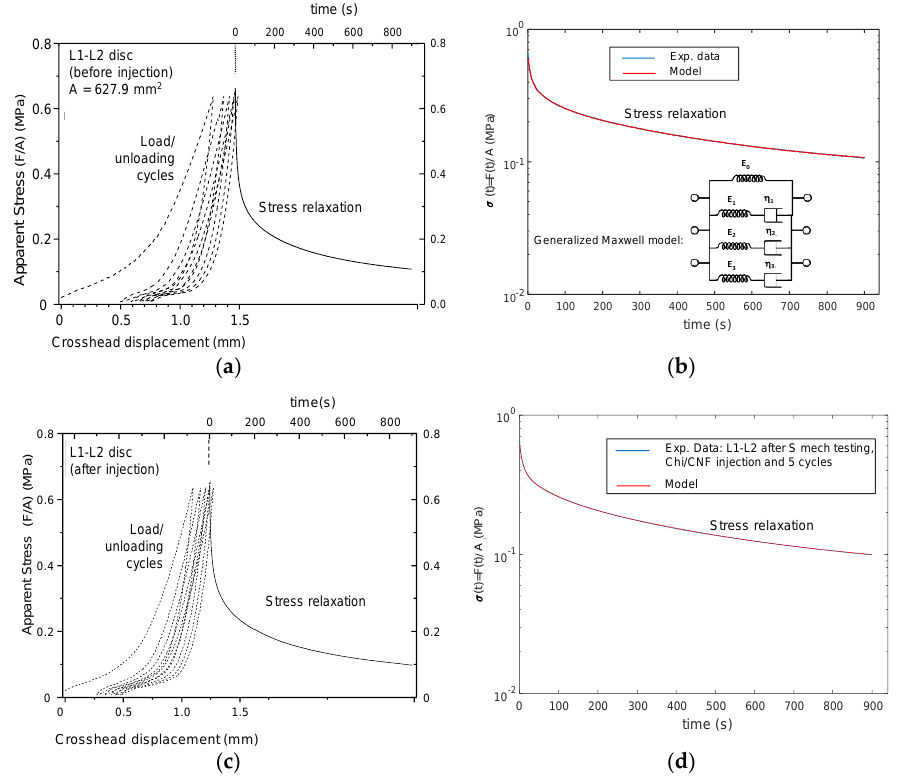
Figure 11. Curves of mechanical tests performed ex vivo in intervertebral disc IVD pig model. Non-injected disc L1-L2 (S): ( a ) Five compression loading/unloading cycles performed at 1 mm/min up to a maximal load of 400 N and, then, stress relaxation for 15 min; ( b ) Modeling of the obtained stress relaxation experiment by using a generalized Maxwell model. After mechanical testing, after injection with 205 µL of cellulose nanofiber-filled chitosan CNF/CHI formulation (2% ( w / w ) CHI/ 0.3% ( w / w ) CNFs) of the same disc L1-L2 (I), this latter was subjected again to mechanical testing ( c ): Five compression loading/unloading cycles performed at 1 mm/min up to a maximal load of 400 N and, then, stress relaxation for 15 min; ( d ) Modeling of the obtained stress relaxation experiment by using a generalized Maxwell model.